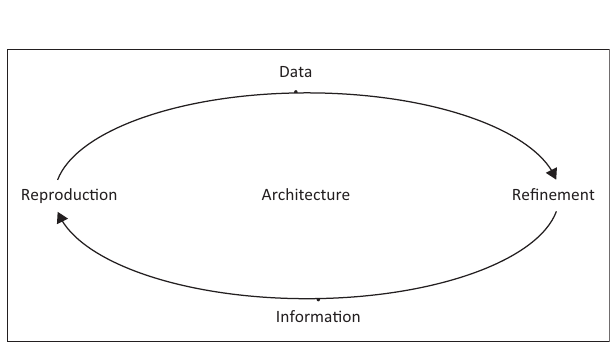
FIGURE 2: The evolving nature of data and